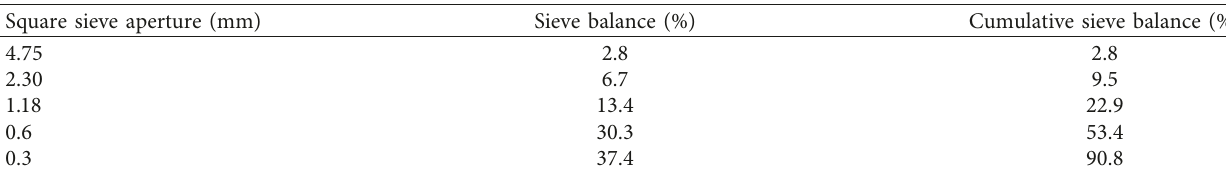
Table 3: Screening results of the fine aggregates.